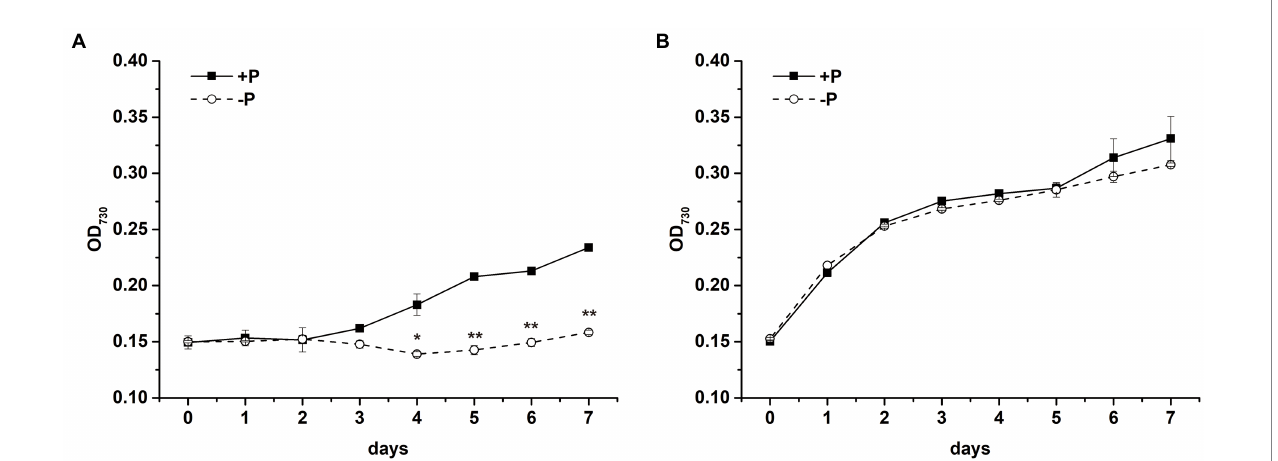
FIGURE 1 Growth curves of S . costatum (A) and P . globosa (B) in +P and − P groups. Error bars show the mean ± standard error (SE) of triplicate treatments. Superscripts indicate significant differences between +P group and − P group according to a two-way ANOVA with a post-hoc test (** p < 0.01, * p <